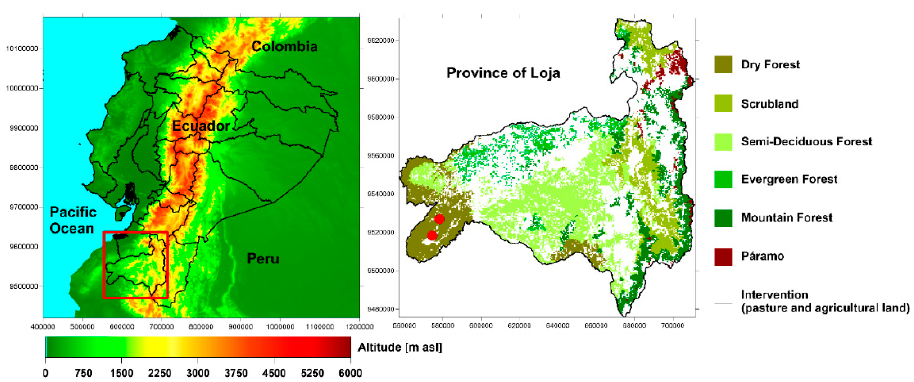
Figure 1. Digital Elevation Model (DEM) of continental Ecuador (left) and natural ecosystems of the province of Loja (right). The map was adapted from the Ecuadorian Ministry of the Environment [32]. The red symbols indicate the sampling point of the Xylaria